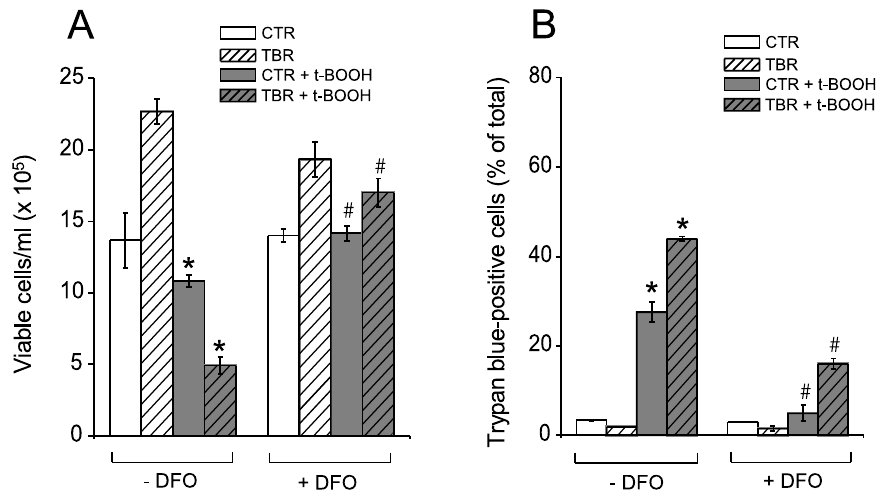
Fig. 2 – t-BOOH-induced death of CTR and TBR lymphocytes is prevented by deferoxamine (DFO). (A) Growth of DFO-treated CTR (white and gray bars) and TBR lymphocytes (white hatched and gray hatched bars) incubated for 4 h in the absence of 500 µ M t-BOOH (white and white hatched bars) or in its presence (gray and gray hatched bars). (B) Death of DFO-treated CTR and TBR lymphocytes incubated for 4 h in the absence of 500 µ M t-BOOH or in its presence. *p < 0 . 05 vs. respective group without t-BOOH in the absence of DFO. # p < 0 . 05 vs. respective group treated with t-BOOH in the absence of DFO.